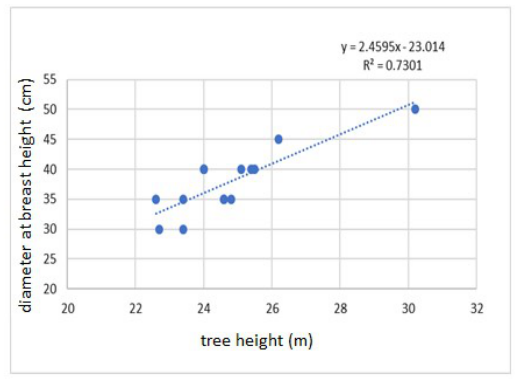
Figure 12 . Relationship between tree height and diameter Figure 13 is a diagram comparing the number of trees with a